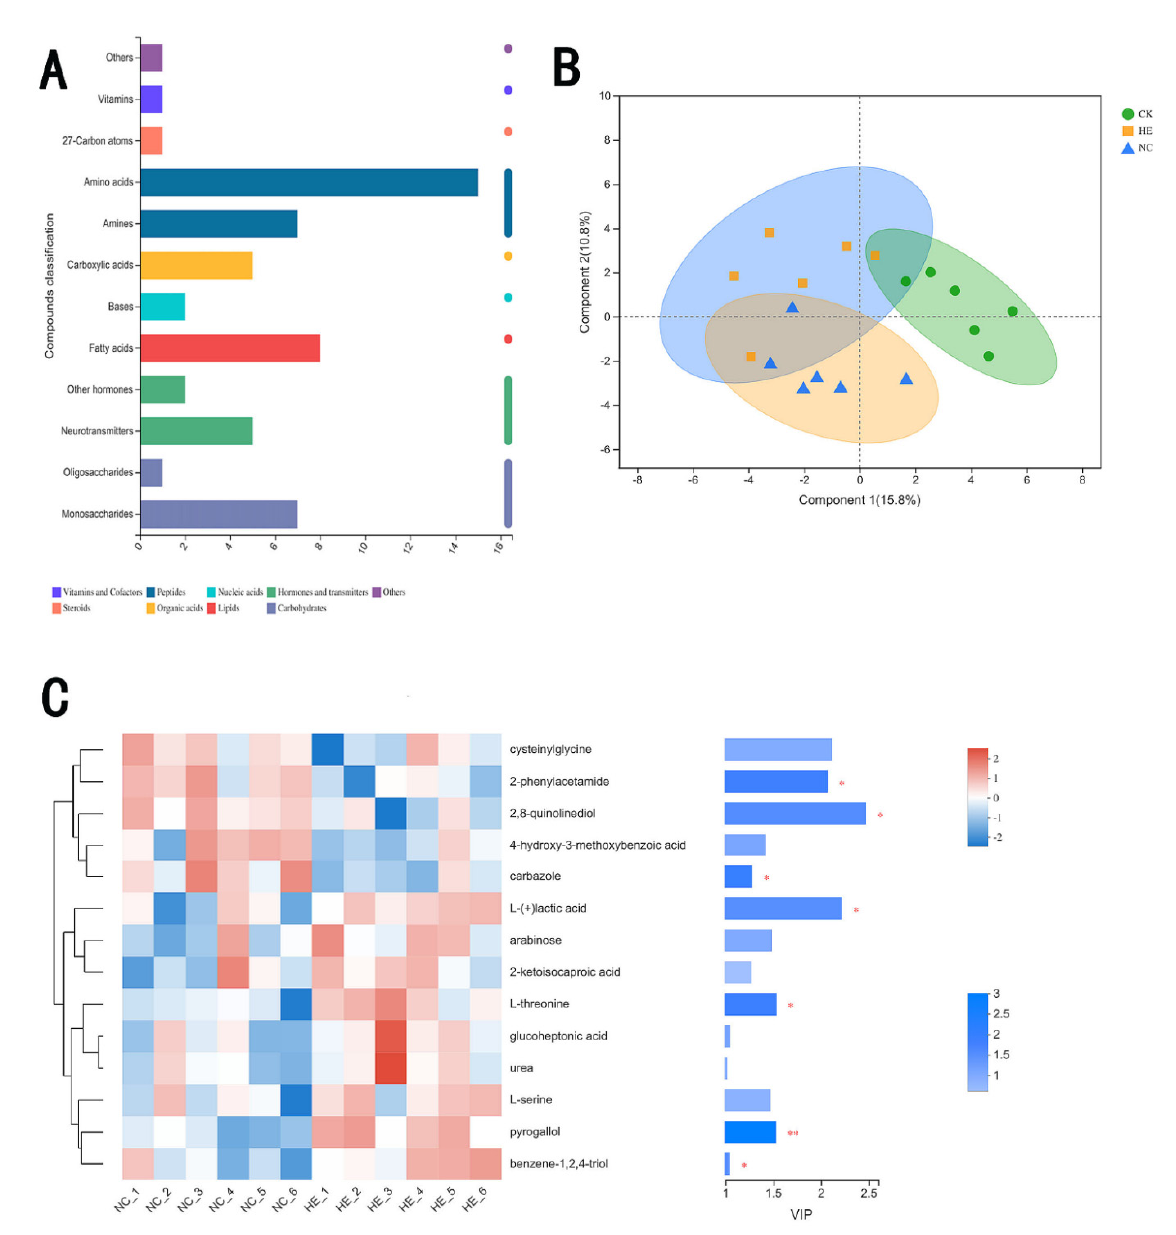
Figure 9. ( A ) Kyoto Encyclopedia of Genes and Genomes (KEGG) compound classification statistics. ( B ) PLS − DA analysis of microbial metabolites in the feces of the mouse groups. ( C ) Variable importance in projection (VIP) analysis of fecal microbial metabolites in the NC and HE